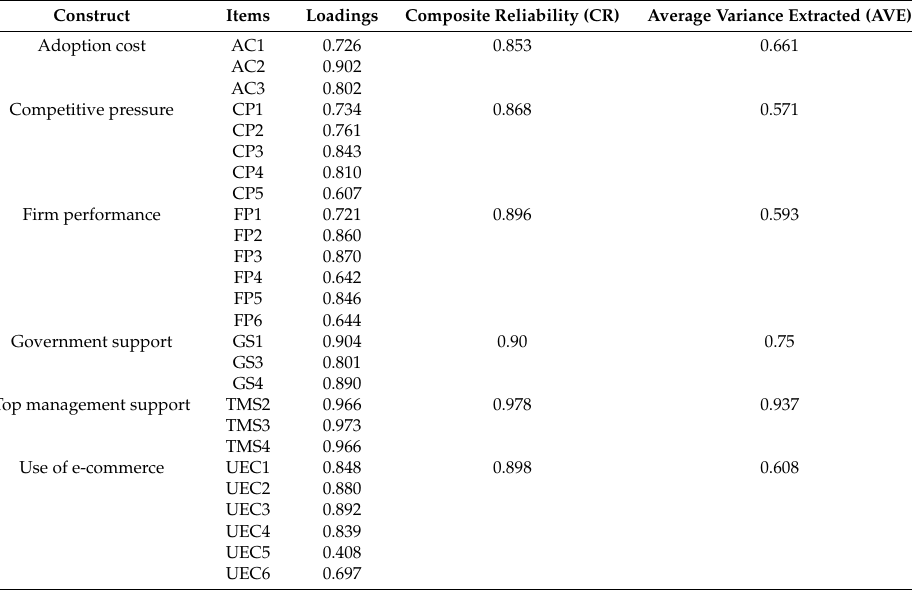
Table 7. Reliability and validity results.